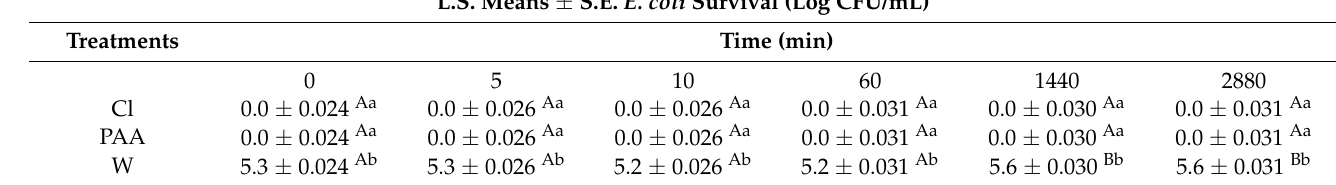
Table 2. E. coli populations in simulated agricultural surface water analyzed by antimicrobial treatment and time. The treatment × time interaction was significant ( p = 0.0001) and did not include pH, turbidity, or temperature effects. Therefore, data associated with pH, turbidity, or temperature are displayed according to treatment and